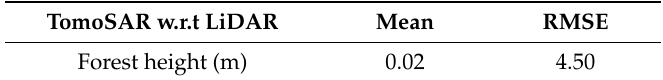
Figure 9. ( a ) The LiDAR CHM. ( b ) The forest height estimated by the W&O-SPICE TomoSAR method. Table 5. The mean and RMSE of the forest height estimated by the W&O-SPICE TomoSAR method with respect to the LiDAR